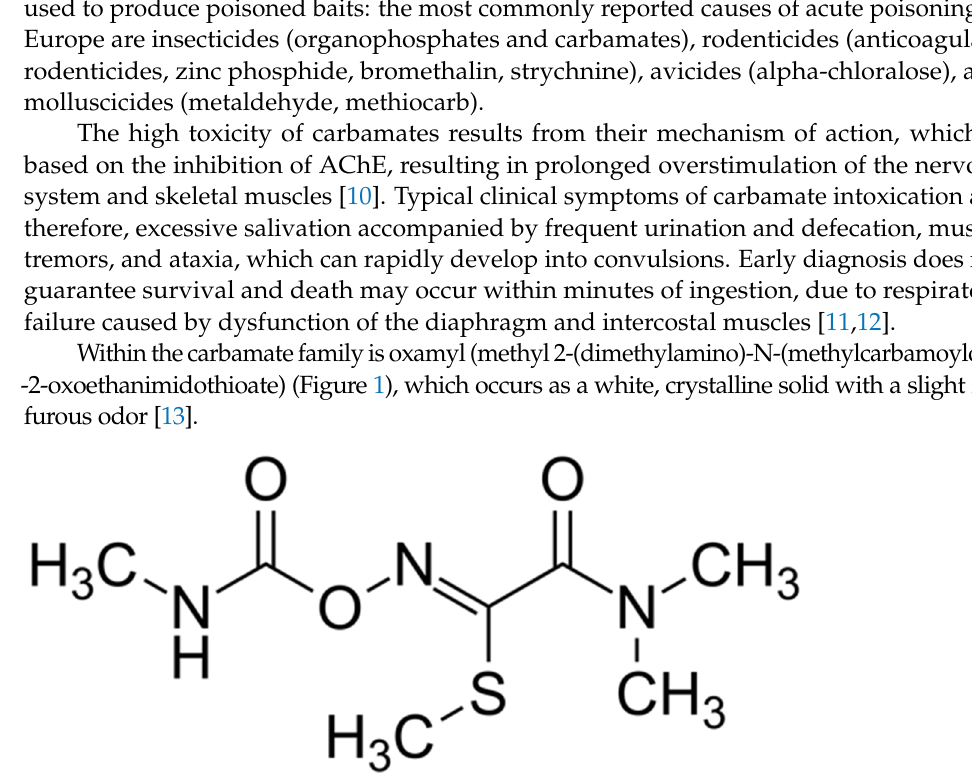
Figure 1. Oxamyl (methyl 2-(dimethylamino)-N-(methylcarbamoyloxy)-2-oxoethanimidothioate).